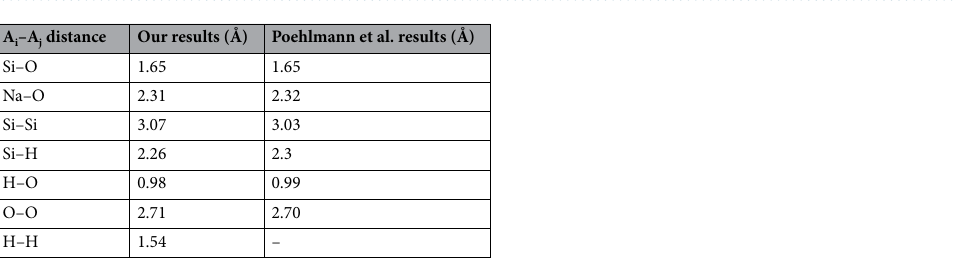
Table 1. A comparison of interatomic distances in the hydrous albite melt estimated from calculated g ij